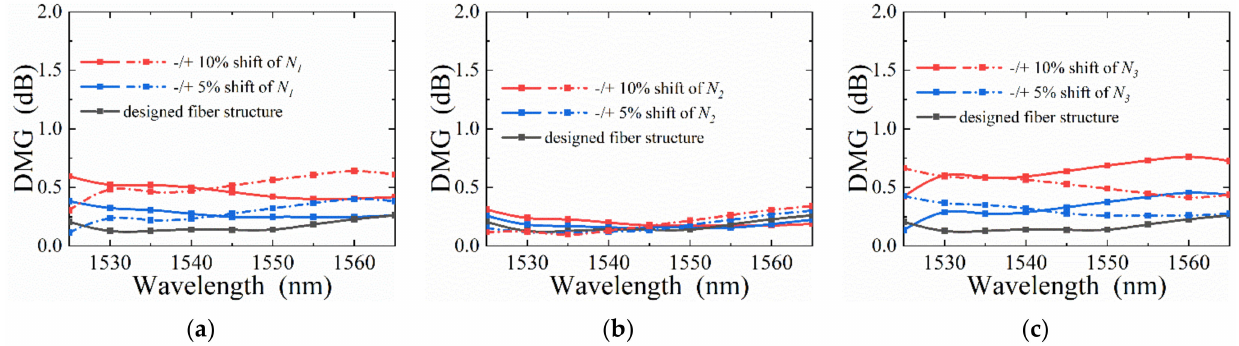
Figure 8. DMG versus wavelength under the shift of doping concentration of each layer, where ( a – c ) corresponds to the N 1 to N 3